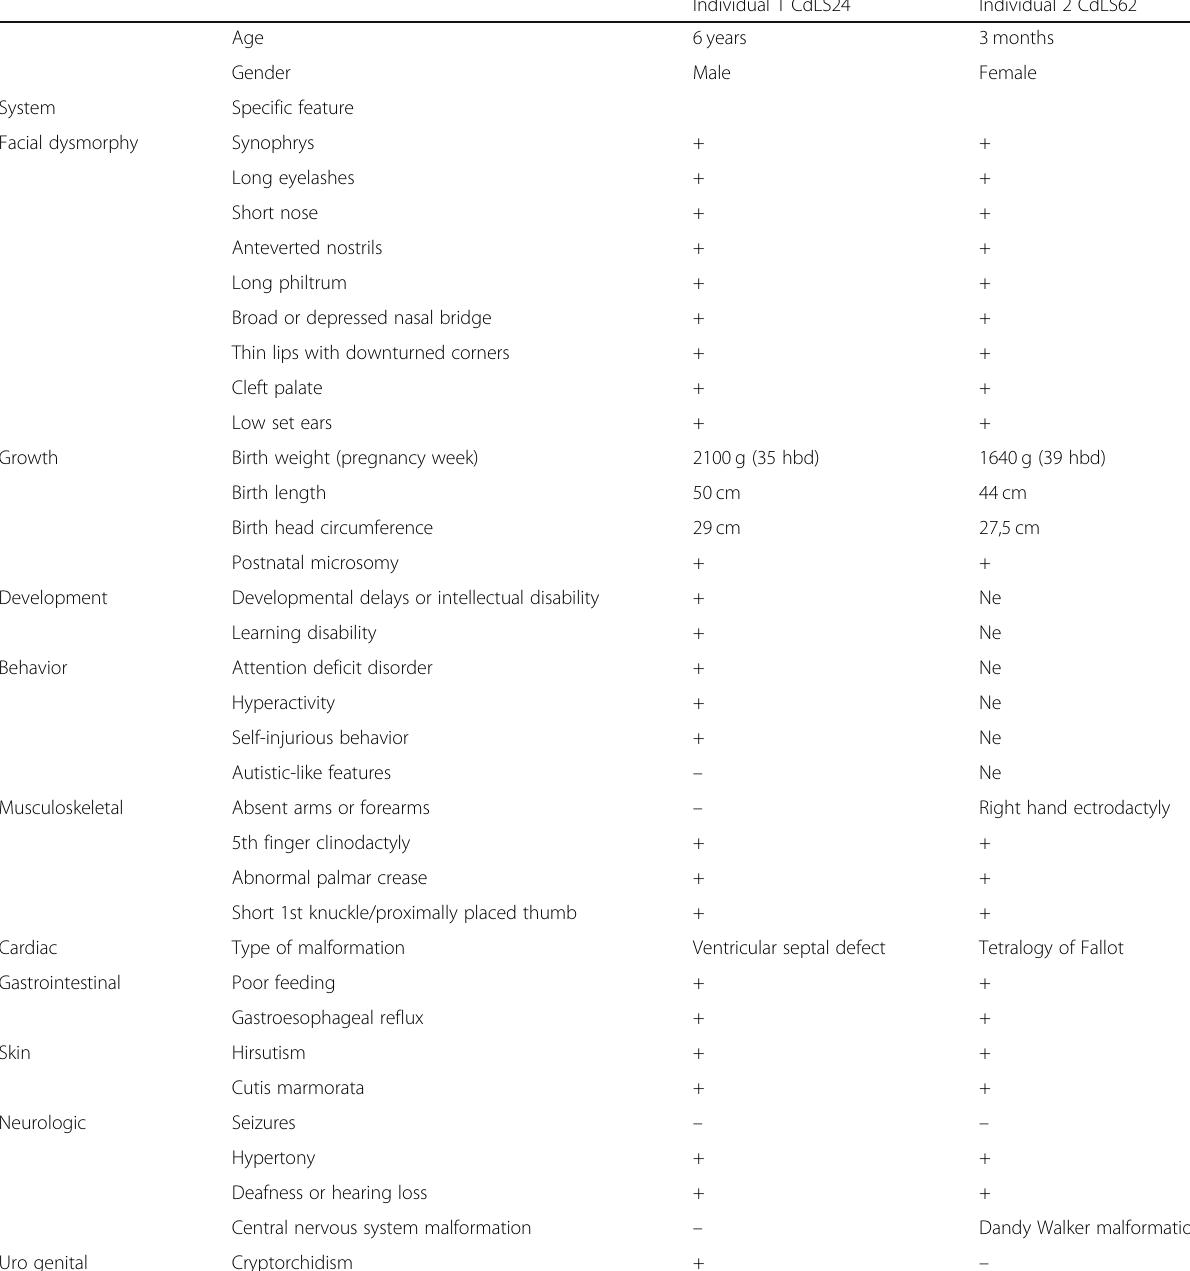
Table 1 Clinical features of CdLS patients enrolled to the